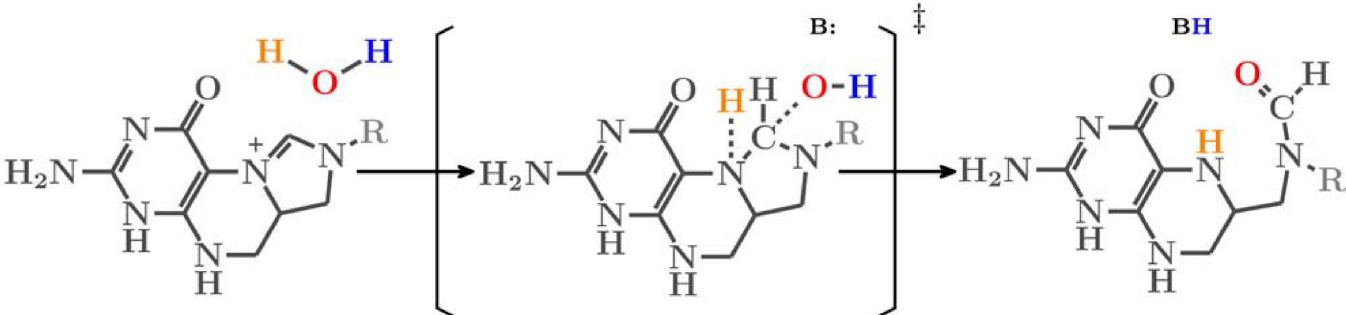
Fig 6. Proposed cyclohydrolase reaction mechanism. ‡ represents transition state.